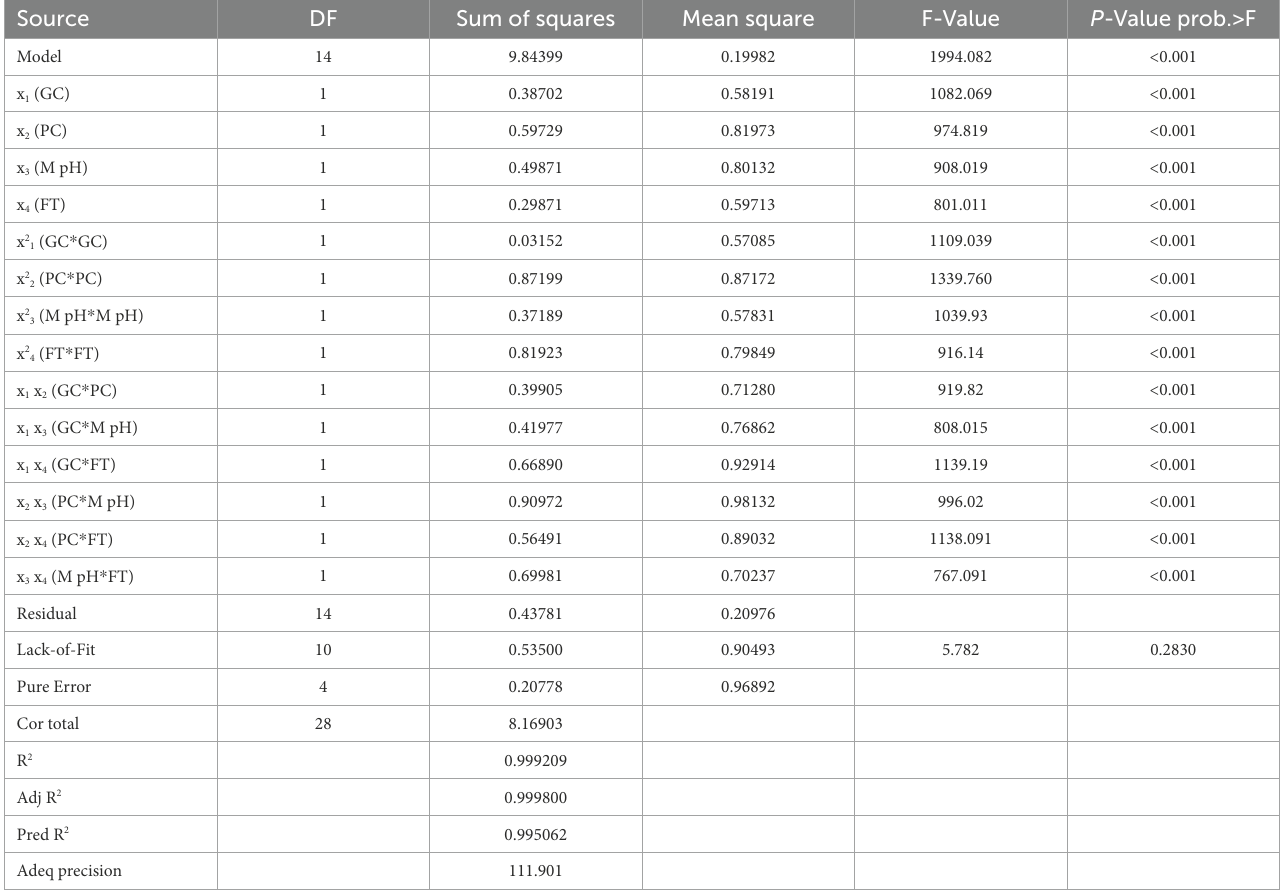
TABLE 4 ANOVA for response surface quadratic regression model of Galactose Rich Heteropolysaccharide production by endophytic fungi Mucor sp. HELF2. Source DF Sum of squares Mean square F-Value P -Value prob.>F